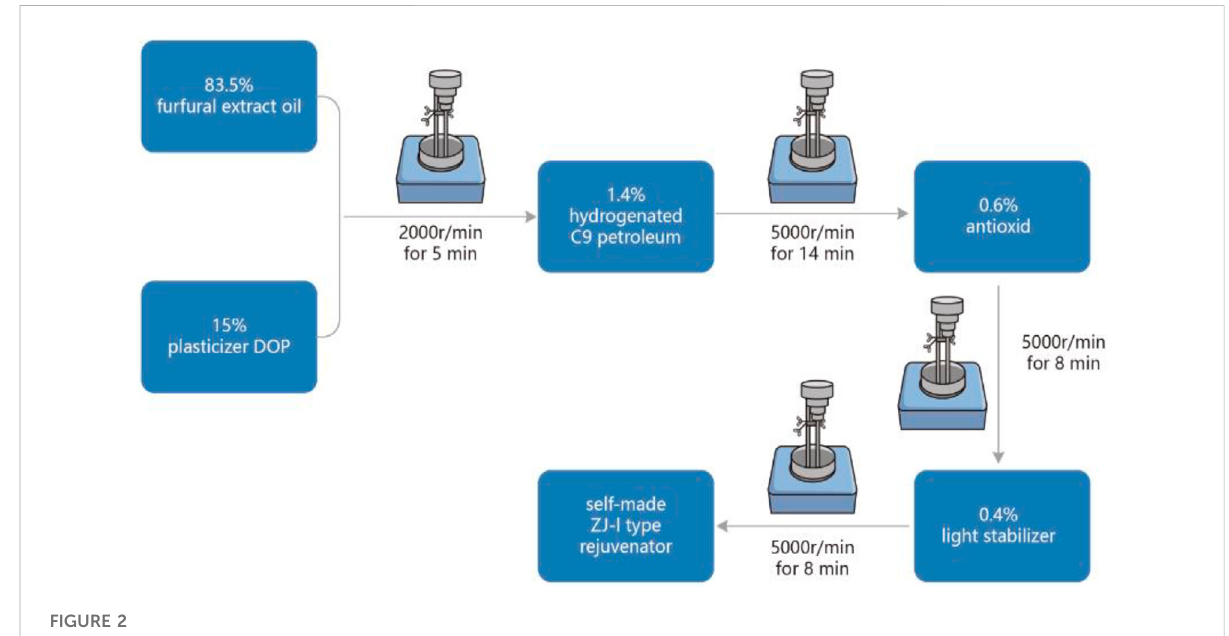
FIGURE 2 Process diagram of rejuvenator preparation.